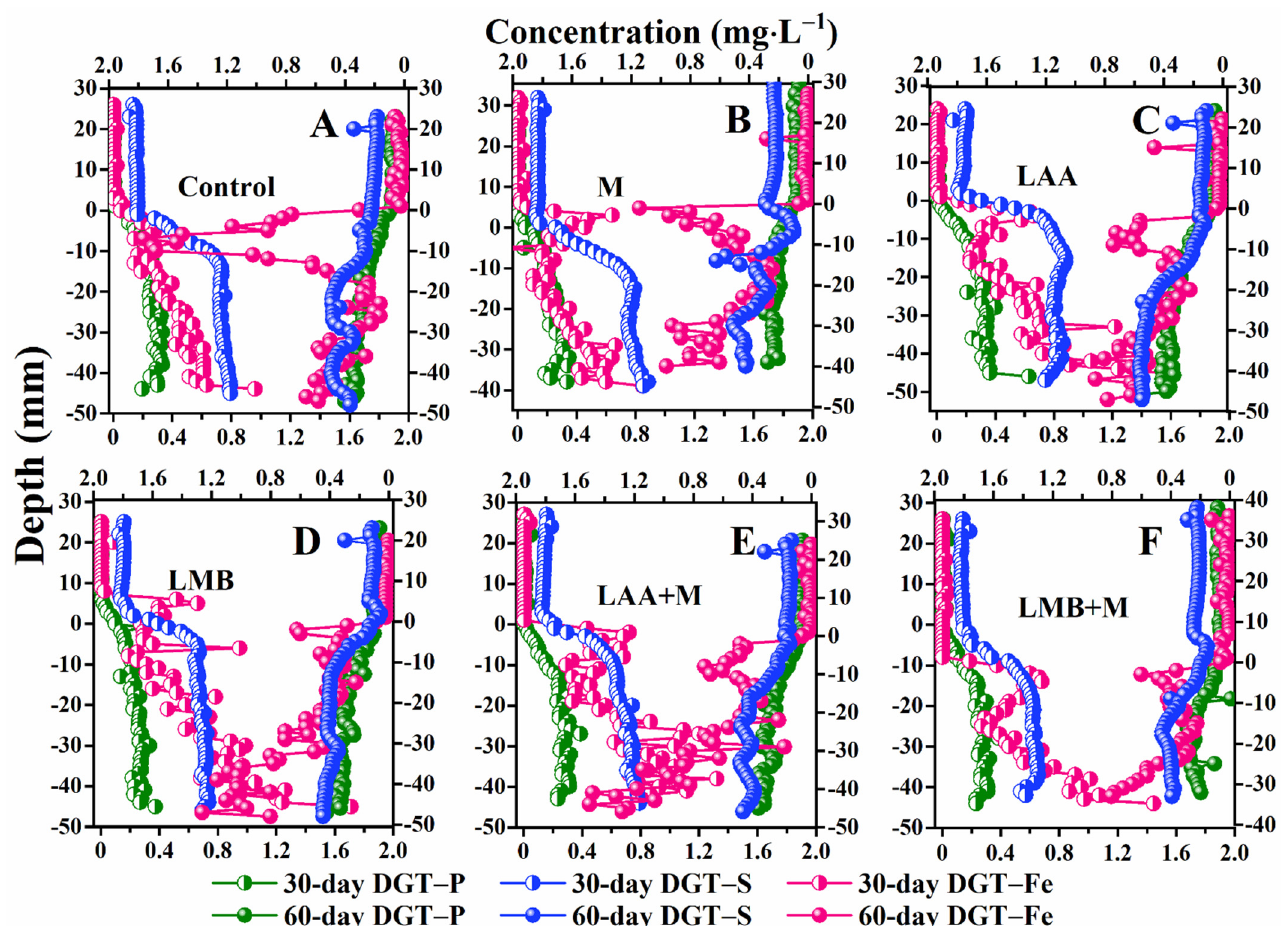
Figure 6. Vertical change of the DGT-labile P (Fe/S) concentrations in sediments of the six treatments groups during the experiment. The location of the sediment–water interface is represented by zero.